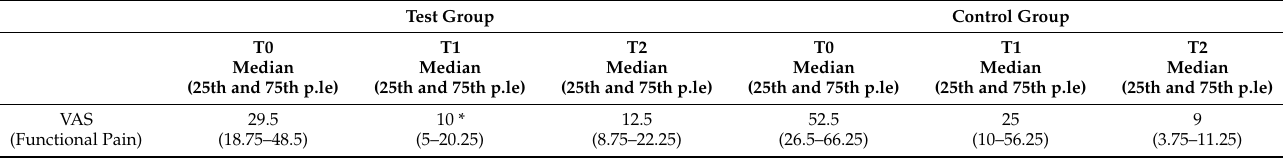
Table 2. Descriptive statistic for functional pain. VAS scores, median, 25th and 75th percentiles.